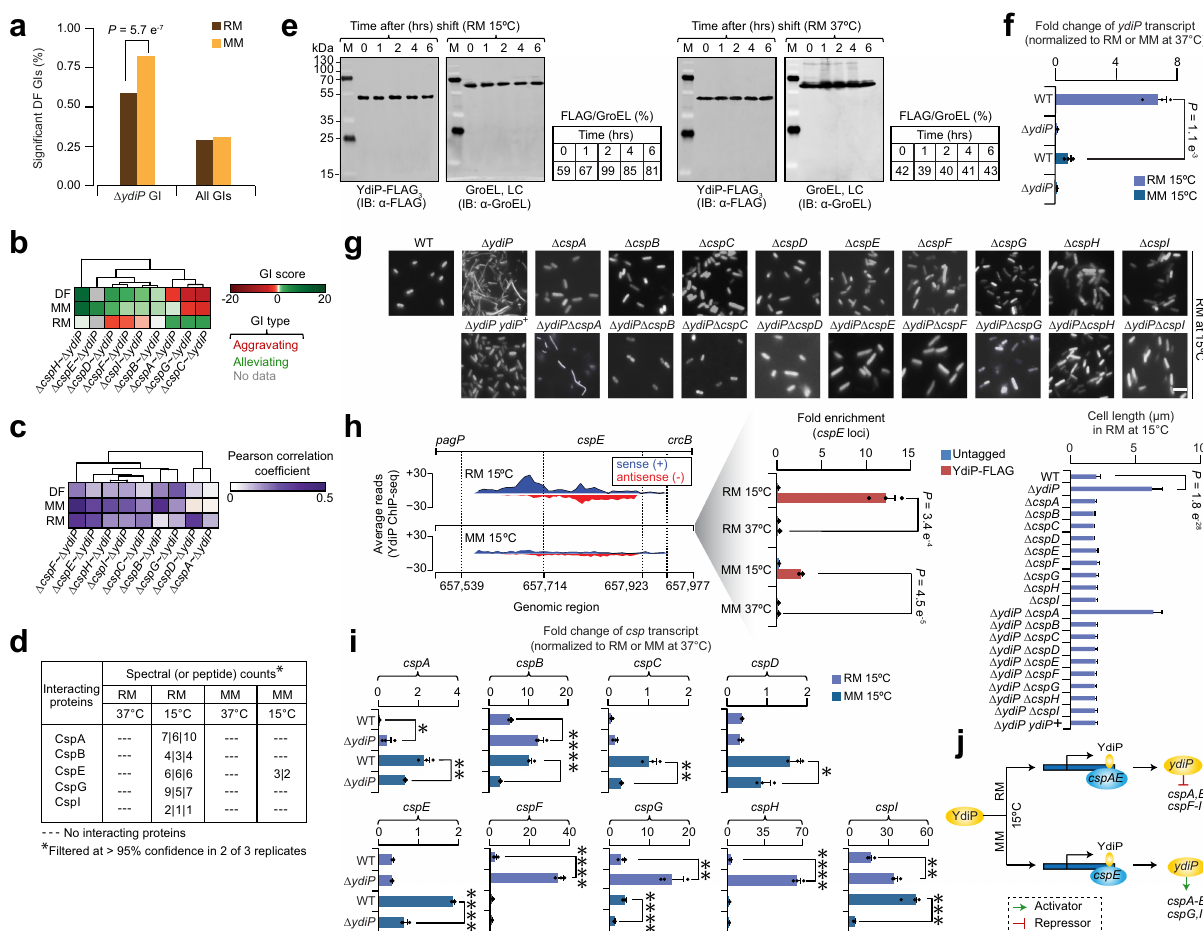
Fig. 6 YdiP regulates cold shock proteins at low temperature. a Signi fi cant ( P = 5.7 e − 7 by Student ’ s two-sided t -test) differential GIs of ydiP with other TF gene mutants in RM and MM. b , c GI patterns ( b ) and correlation ( c ) pro fi le of ydiP in static and differential networks with genes involved in cold